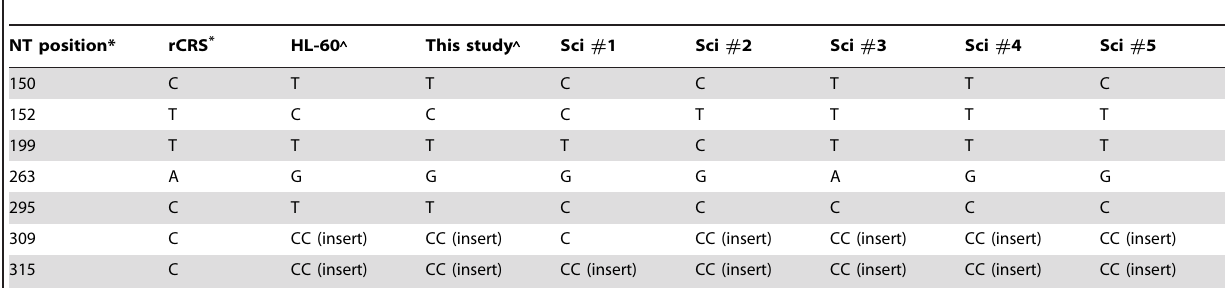
Figure 2. Schematic illustrations of the experimental setup and the extraction process. (A) Light from three different lasers is coupled into the back aperture of a microscope objective. The ultraviolet (UV) pulse, fluorescence, and infrared (IR) trap lasers are overlapped and used for cell lysing, mitochondrion identification and trapping respectively. A pump applies positive pressure to a femtopipette tip to balance against the capillary draw of fluid up inside the tip. (B) A single cell, isolated from other cells, is lysed with a UV pulse laser (violet hourglass). (C) Cell lysis occurs and organelles escape from the cell. (D) A trapped organelle is identified as a fluorescently-labeled mitochondrion with the fluorescence laser (IR trap is designated by the red hourglass; overlapping fluorescence excitation laser is not shown). (E) The trapped organelle is positioned near the end of a femtopipette tip. (F) The tip is positioned sufficiently close to directly capture the mitochondrion or backing pressure from the pump is removed and capillary action draws the mitochondrion into the femtopipette. Full details of the extraction protocol are described in the methods section. A time- edited video showing the entire process is found in the Supplementary Video (S1) available online. Table 1. The sequence variation of the hypervariable region 2 (HV2).